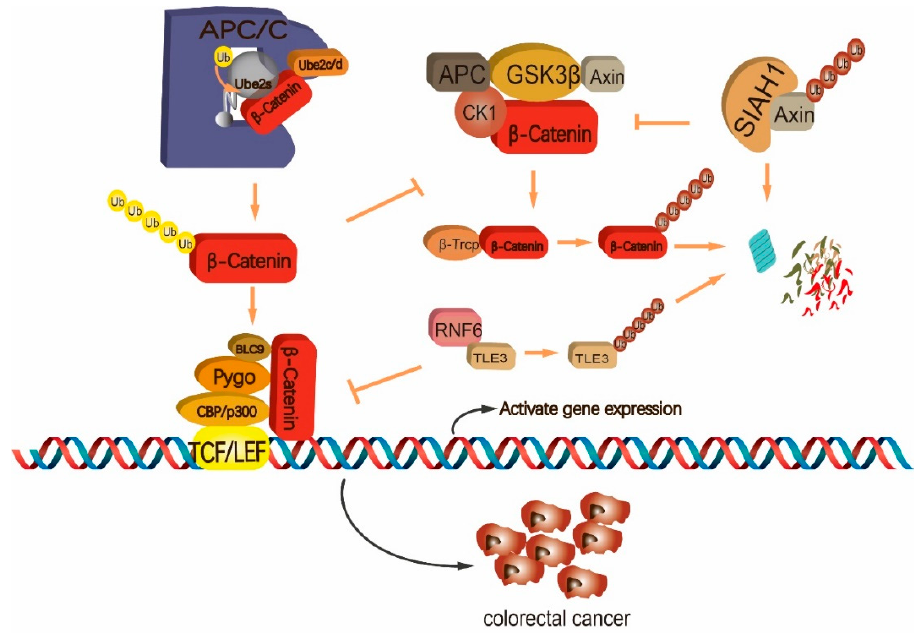
Figure 2. Ubiquitination-monitored regulation of the Wnt / β -Catenin pathway in colorectal cancer (CRC) cells. UBE2S coordinates with the E3 complex anaphase-promoting complex / cyclosome (APC / C) to mediate K11-linked ubiquitin polymer on β -Catenin, which prevents beta-transducin repeat containing E3 ubiquitin protein ligase ( β -TrCP)-orchestrated degradation of β -Catenin. RING-type E3 ring finger protein 6 (RNF6) ubiquitinates the inhibitor of β -Catenin, transducin-like enhancer of split 3 (TLE3), for degradation, which enhances the transcriptional activity of β -Catenin. SIAH1 ubiquitinates Axin for degradation, and thus blocks β -TrCP-mediated recognition and degradation of β -Catenin. Arrows represent enhancement and T-bars represent inhibition. Table 1. Ubiquitination factors involved in regulating CRC.